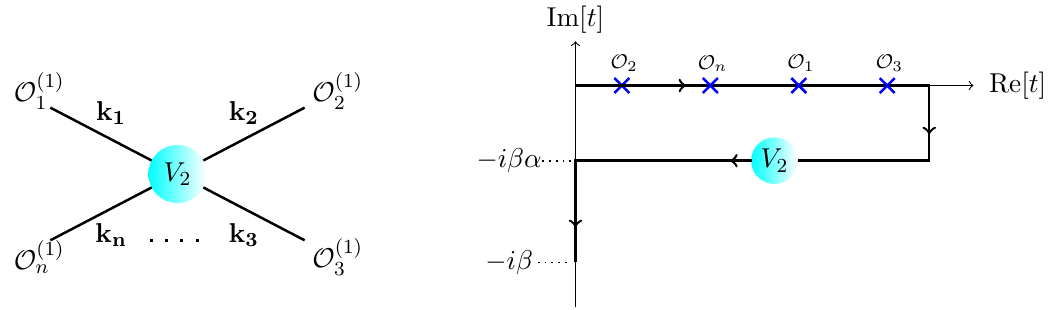
Figure 3 . A diagrammatic expansion of the correlator with the external legs on the same branch of the SK contour. The result does not depend on the width (cid:12)(cid:11) .